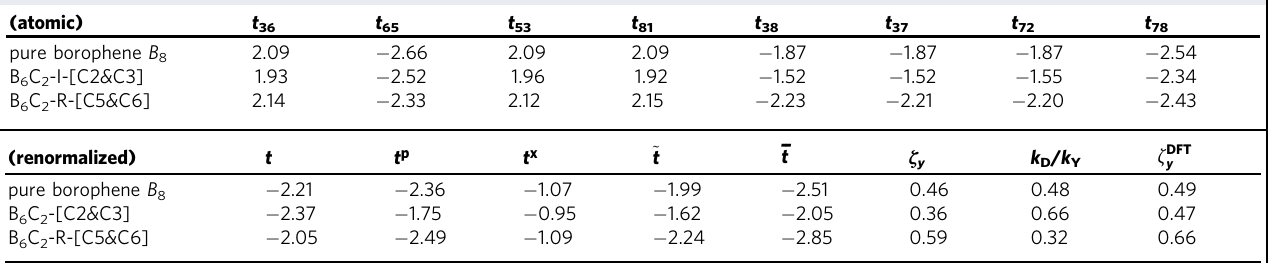
(top) ab initio hopping matrix elements (in eV) for borophene and C-doped borophene obtained from Wannier functions. Conventions for labeling of the hopping matrix elements are given in Fig. 2a. (bottom) Renormalized parameters of Fig. 2c. ζ y is the tilt parameter and k D / k Y quanti fi es the location of Dirac